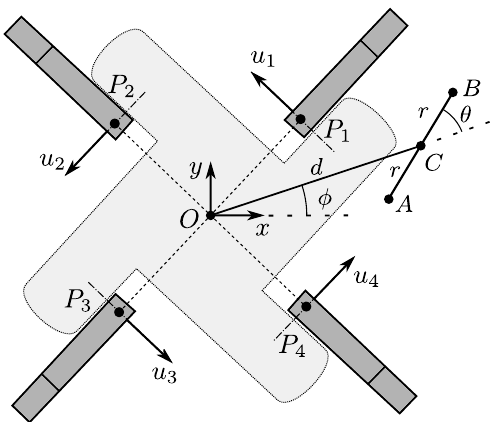
Figure 5. Top view of the path parametrization. Only the upper arms of the robot are